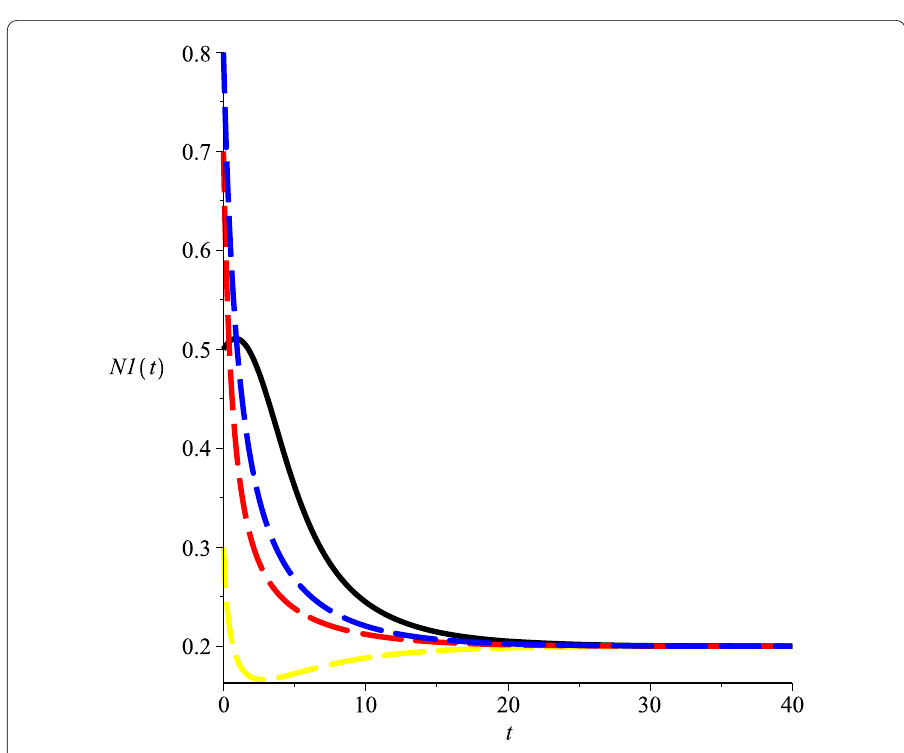
Figure 6 Numeric simulations of the second components of system (5.1) with m = 0.3, the initial conditions ( x (0), y (0)) = (0.5,0.1),(0.8,1),(0.3,3), and (0.7,2), respectively